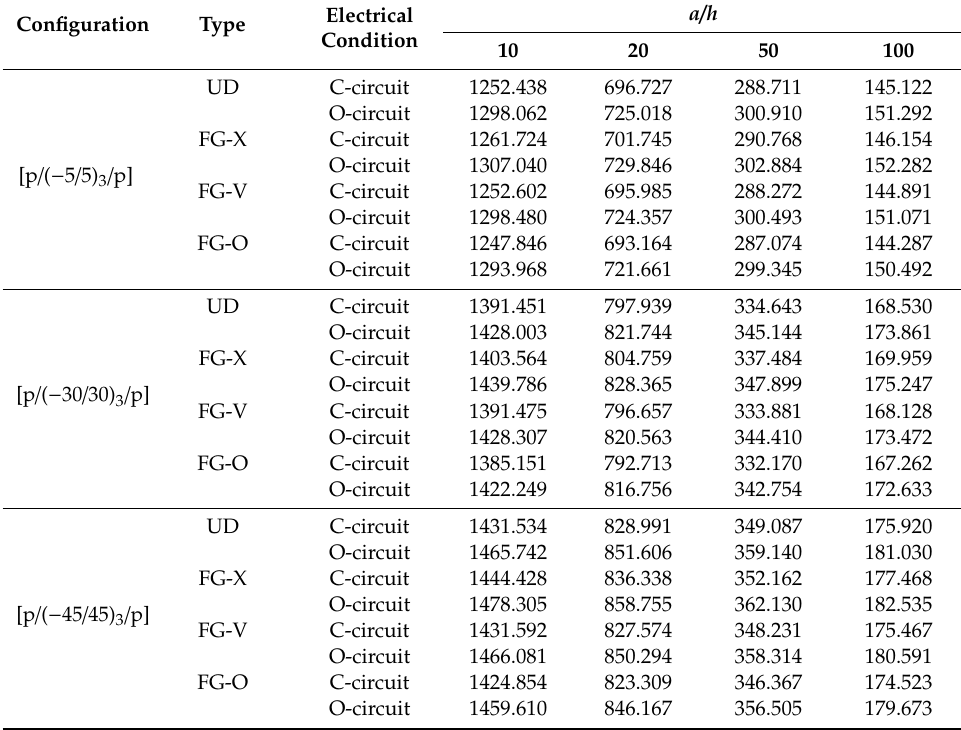
Table 11. The fundamental natural frequencies ω (Hz) of anti-symmetric angle-ply [p / ( − θ / θ ) 3 /